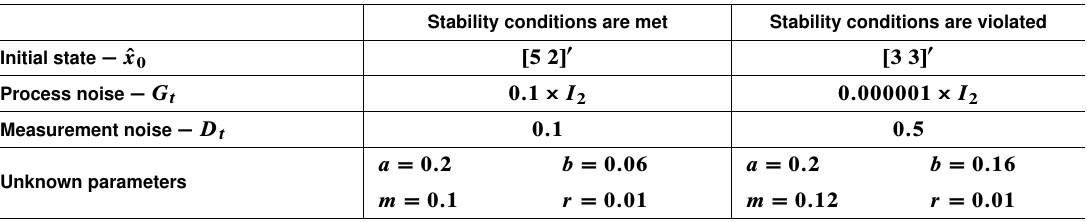
Stability conditions are met Stability conditions are violated